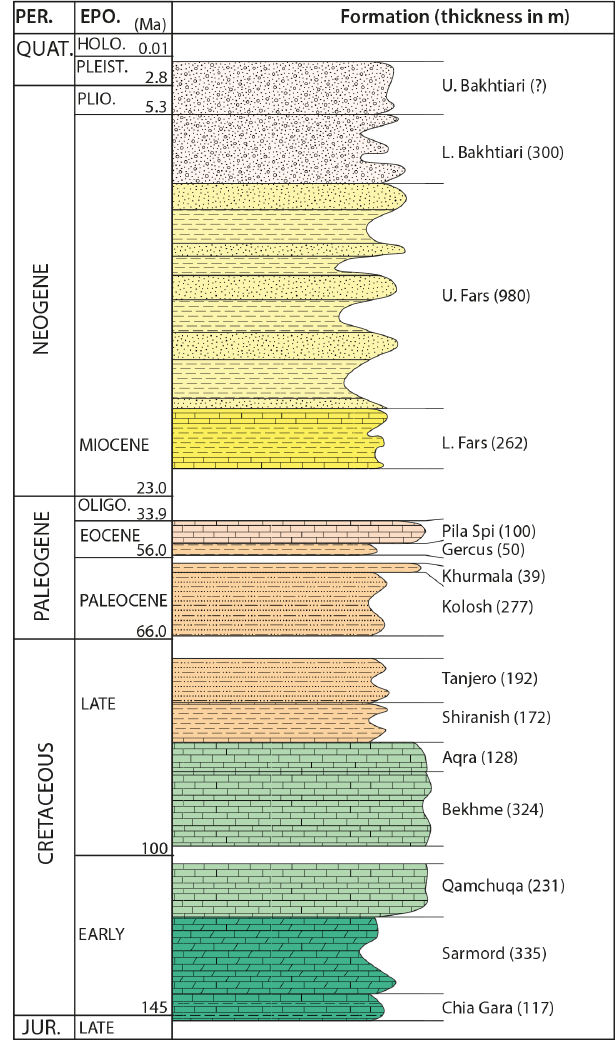
Figure 3. Stratigraphic column of the exposed rock units in the area. Thicknesses are given as in well Bijeel-1 (Fig. 2), which is located 5km to the south of Perat Anticline (modified after Law et al., 2014). The column is scaled to the stratigraphic